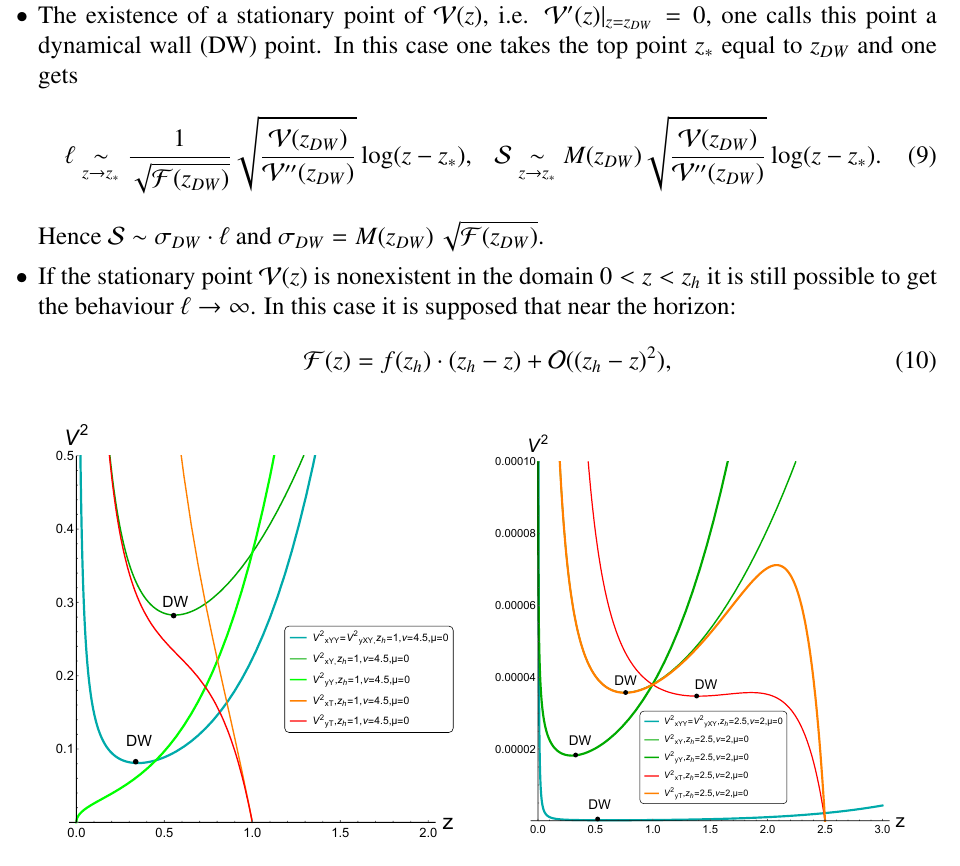
2 ( z ) for the di ff erently oriented spatial, temporal V 1, di ff erent z h and ν −